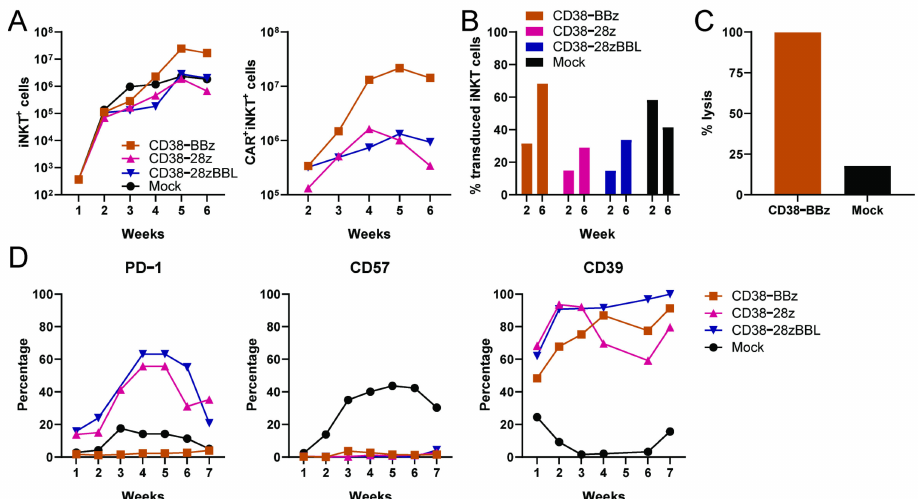
Figure 5. CD38-dependent expansion and activation of functional CD38-CAR iNKT cells. CD38-CAR iNKT cells with different costimulatory domains and mock-transduced cells were weekly re-stimulated with irradiated CD38 + UM9 cell line at a CAR + iNKT:/target ratio of 3:1, starting 4 days after transduction. ( A ) Depicted are the calculated numbers of total iNKT cells (left) and of CAR + iNKT cells (right). ( B ) The percentage of CAR + iNKT cells in the culture at Week 2 and Week 6. ( C ) Cytotoxic activity of CD38-CAR vs mock-transduced iNKT cells towards a CD1d negative primary MM cell sample at the end of the cultures. ( D ) Graphs depict the expression of PD-1, CD57, and CD39 on iNKT cells. Similar results were observed in a second independent